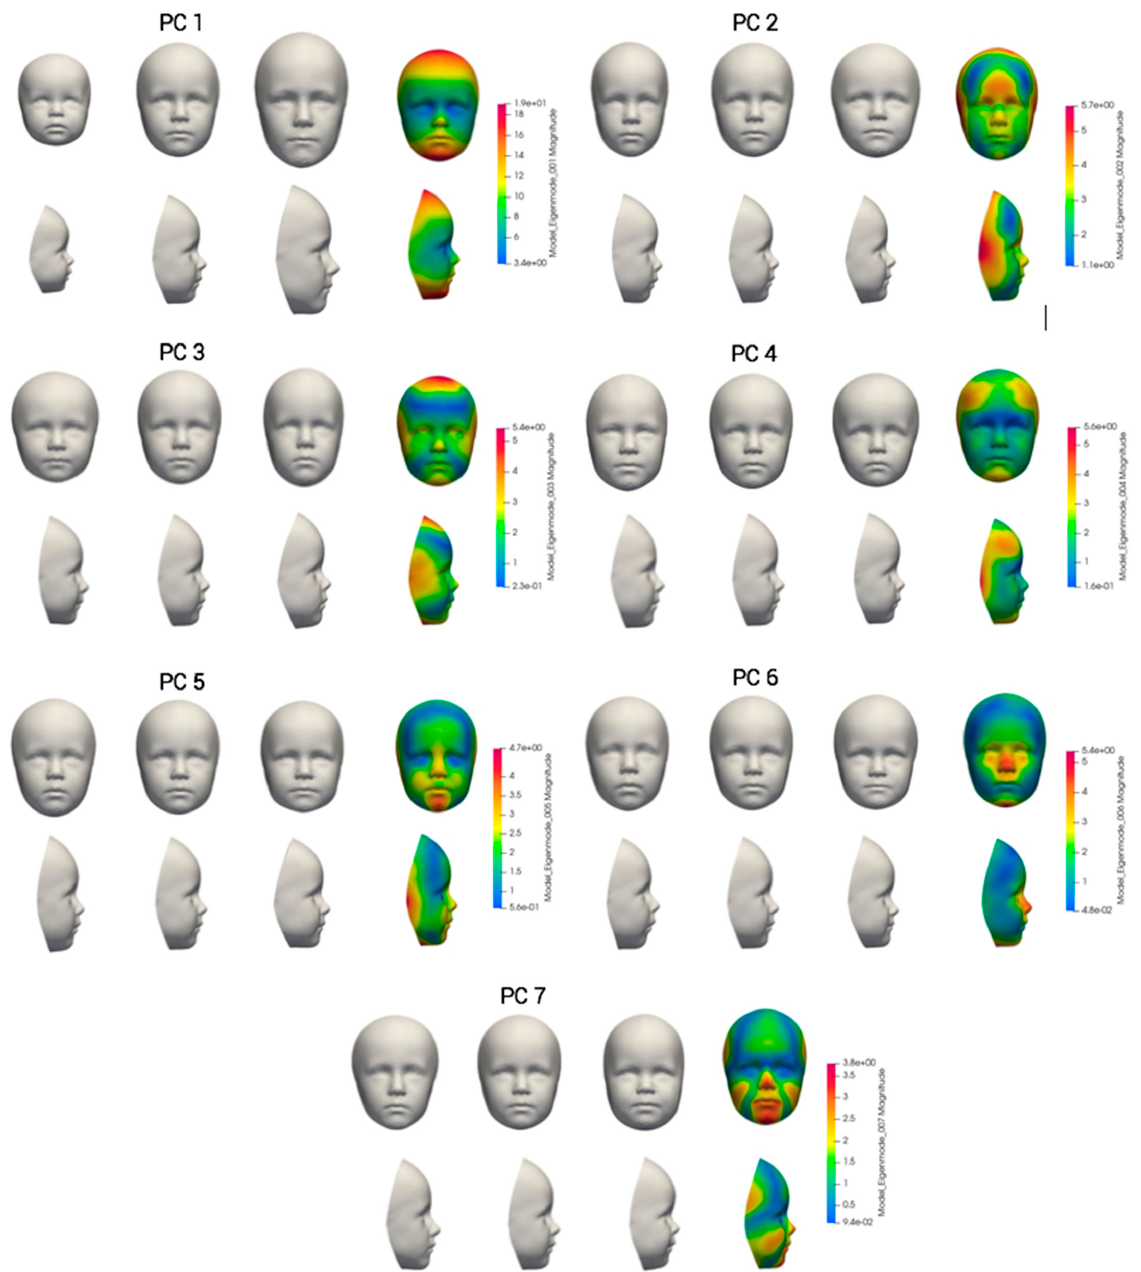
Figure 6. Visualisation of the first seven principal components. Each principal component is shown as the mean, − 3 (left) and +3 (right) standard deviations together with the colour map of the magnitude of displacement (projected on the mean) of the respective principal component.